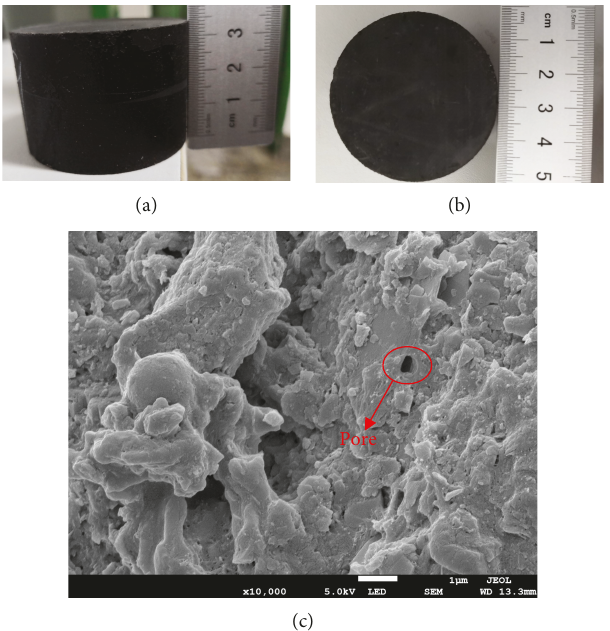
Figure 8: Shale sample: (a) vertical section, (b) cross section, and (c) image from SEM